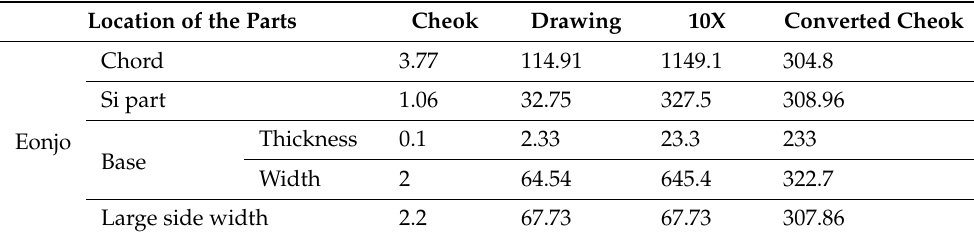
Table 6. Comparison of Eonjo